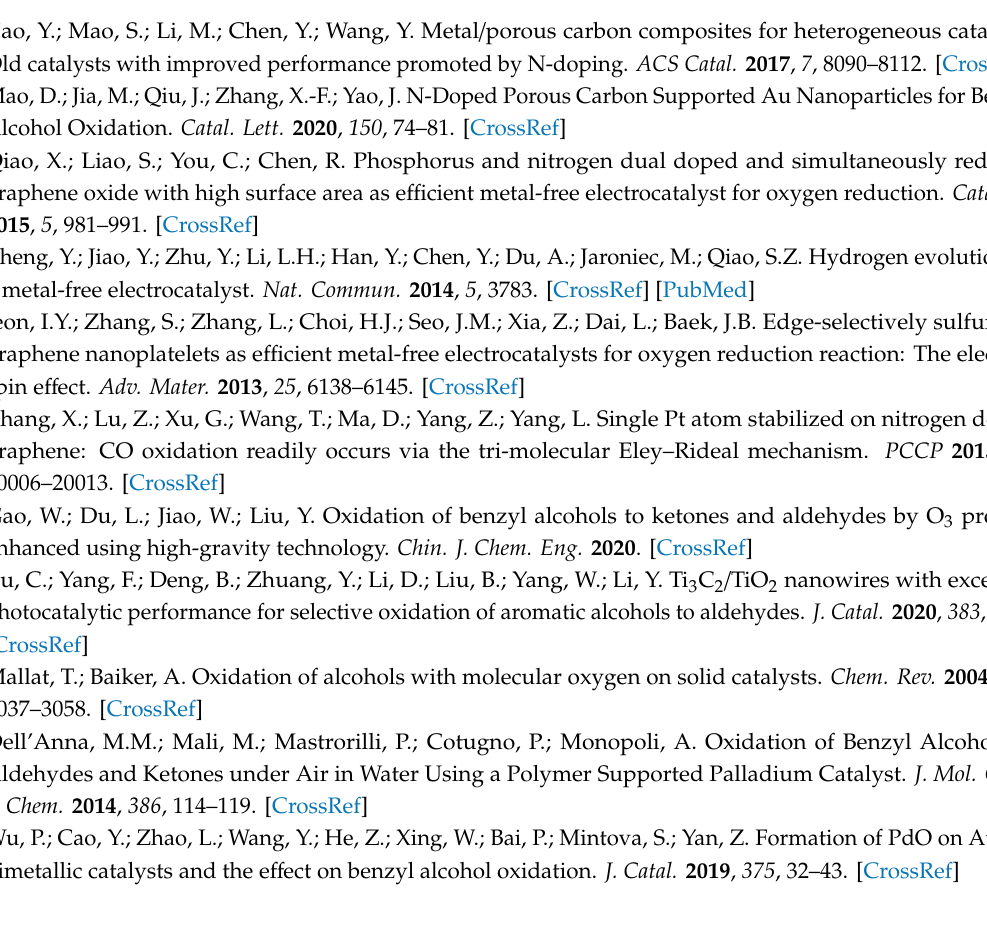
Figure S1: EDX spectrum of (1%) NDG / MnCO 3 –(1%) ZrO 2 nanocomposite. Figure S2: Particle size distribution